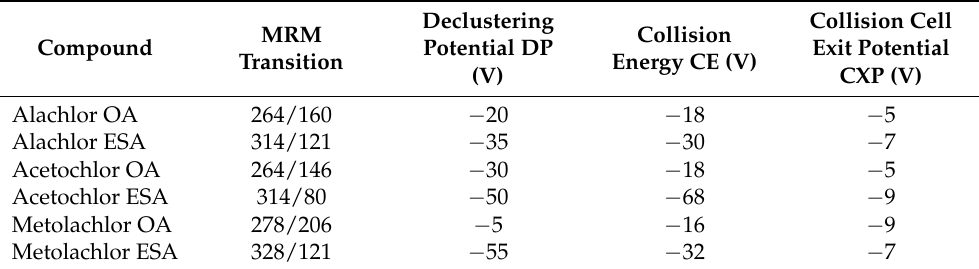
Table 2. Optimization of MS-MS conditions for the analysis of the photocatalysis degradation products.